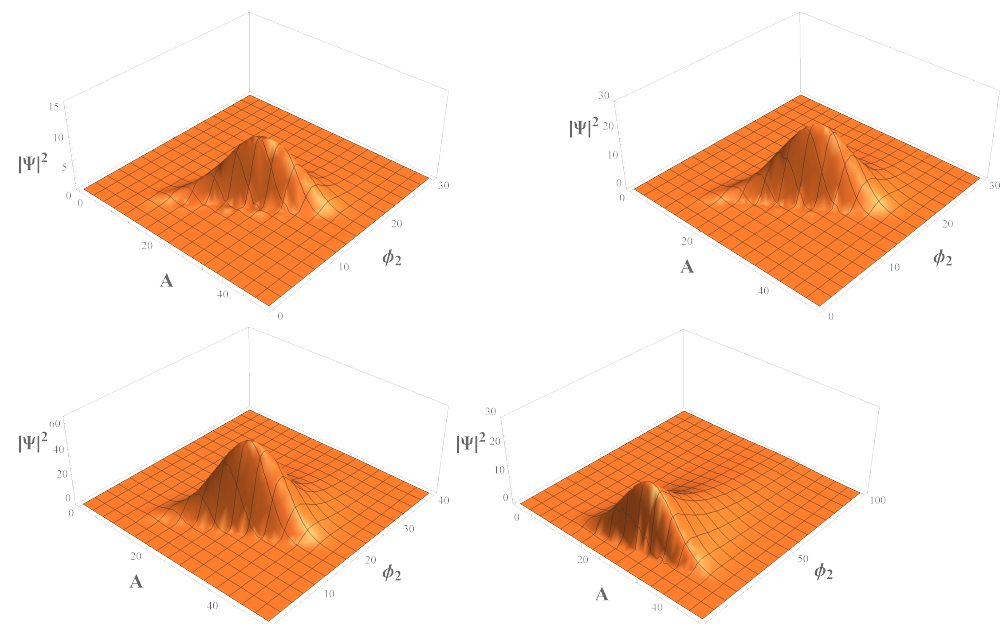
Figure 3. Phantom scenario. These figures show the probability density of the wave function (82) for the values of Q = 2 and Q = 0 (top panels from left to right, respectivley), and Q = − 2 and Q = − 4 (bottom panels from left to right, respectively). We use arbitrary units, namely, ν = 10, λ 1 = 10.5, λ 2 = 6/ λ 1 , V 1 = 0.1, V 2 = 10 − 5 , r 1 = 49, r 2 = 1.5, a 3 = − 2.3, and p 3 = 0.326878, and the bounce in the quintessence field φ 1 = 1.455. The remaining constants can be obtained from the aforementioned values. Additionally, for Q = 2,0 we take Ψ 0 = 10 − 3 ,10 − 2 respectively; then, for Q = − 2, − 4 we √ chose Ψ 0 = 10 − 1 ,1/ 10 respectively. Note that the probability density tends toward the phantom sector when the factor ordering constant Q (cid:28)